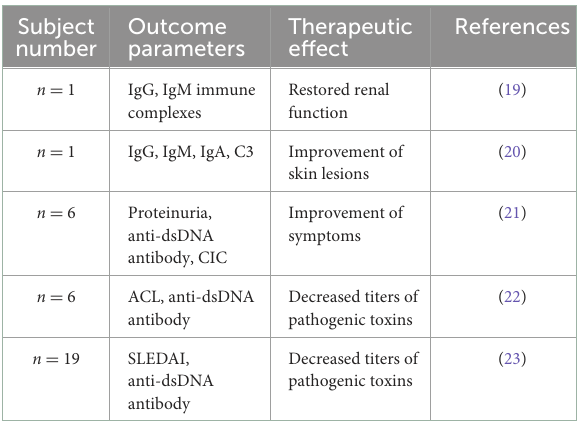
TABLE 1 A summary of the case reports with the application of Selesorb in the treatment of systemic lupus erythematosus